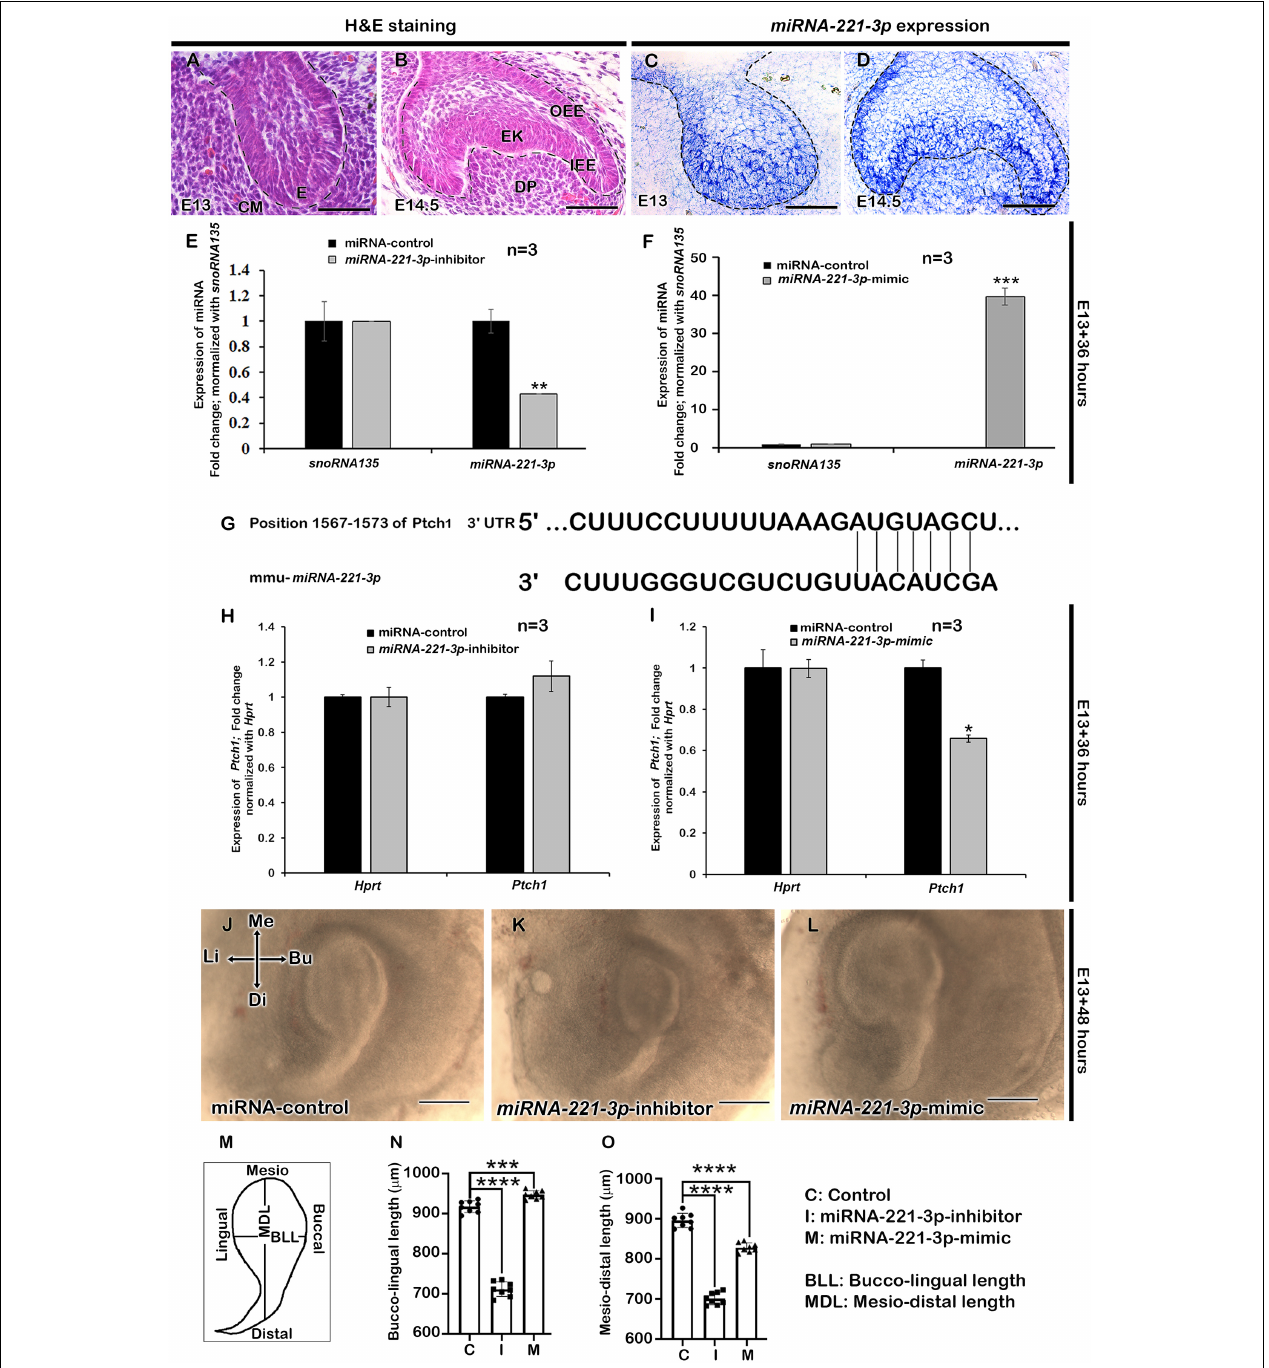
FIGURE 1 | Expression of miRNA-221-3p and loss and gain of function in developing tooth germ. H&E staining showing the developing tooth germ at the bud and cap stage (A,B) . Section in situ hybridization showing expression of miRNA-221-3p along the invaginated epithelium at the bud stage (C) and along the IEE, OEE, EK, DP, and cervical loop at the cap stage (D) . Mimic and inhibitor significantly altered the miRNA expression level of miRNA-221-3p at E13 for 36 h ( E,F , n = 3) (corresponding to data in Supplementary Table 2A ). Conserved seed sequence of miRNA-221-3p with Ptch1 gene (G) . The expression level of Ptch1 increased with miRNA-221-3p inhibition ( n = 3), while decreased with mimic ( H,I , n = 3) (corresponding to data in Supplementary Table 2B ). The culture of tooth germs with mimic and inhibitor at E13 for 2 days show alteration in the length of developing tooth mesio-distally and bucco-lingually ( J–O , n = 8). The dotted lines define the boundary of epithelium and mesenchyme (A–D) . H&E, hematoxylin and eosin staining; E, enamel organ; IEE, inner enamel epithelium; OEE, outer enamel epithelium; EK, enamel knot; DP, dental papilla; Me, mesial; Di, distal; Bu, buccal; Li, lingual. Data were evaluated for statistical significance using unpaired, two-tailed t -test. *, **, ***, and **** indicate p < 0.05, 0.01, 0.001, and 0.0001, respectively. Scale bars: 500 µ m (J–L) , 50 µ m (A–D) .